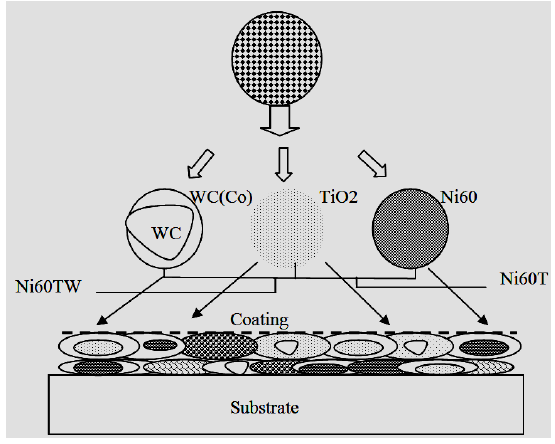
Figure 9. Idea of composite ceramic coatings preparation.